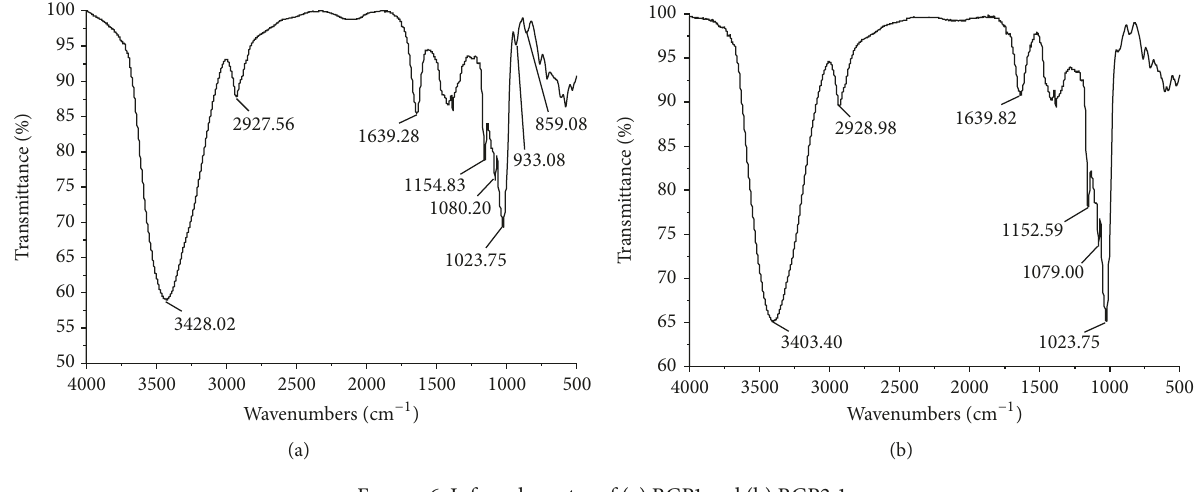
Figure 6: Infrared spectra of (a) RGP1 and (b)